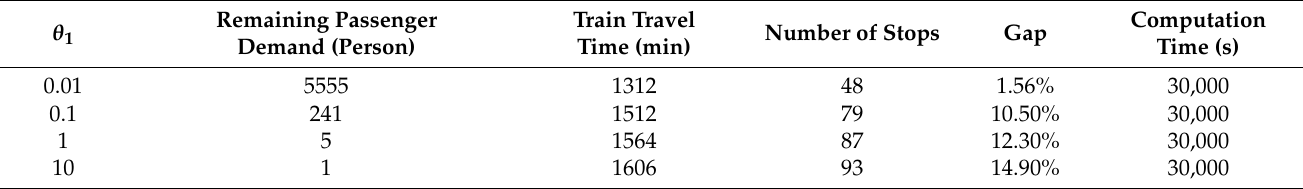
Table 11. The results of the series of